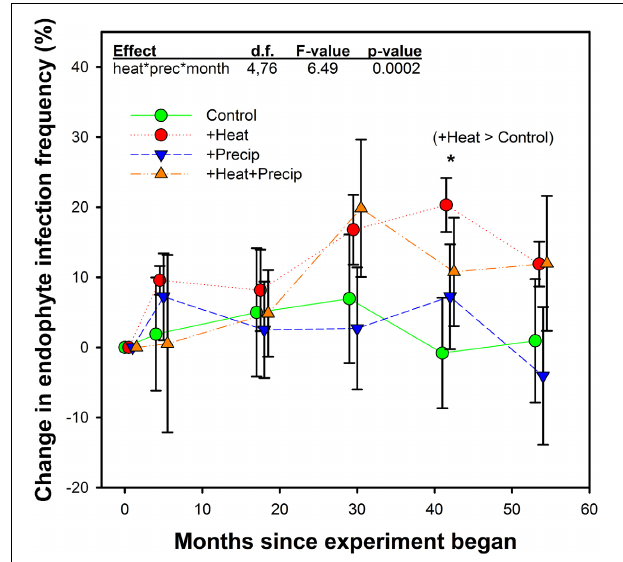
FIGURE 3 | Average ( ± SE) change in endophyte infection frequency within the tall fescue population in each plot over the 5 years study in heated and non-heated, ambient temperature treatments. Points are slightly offset to clarify presentation, but measurements occurred at the same time for all treatments. Initial endophyte infection frequency averaged 41.1% ( ± 3.3) across the site. Plot-level initial (June 2009) individual values were set as the zero point in this figure, and change from these values were calculated for measurements which occurred in Octobers from 2009–2013. The highest order significant interaction between heat, precipitation, and month since project began is shown, along with the only significant treatment comparison. See Table 2 for full statistical results. ∗ p = 0 .